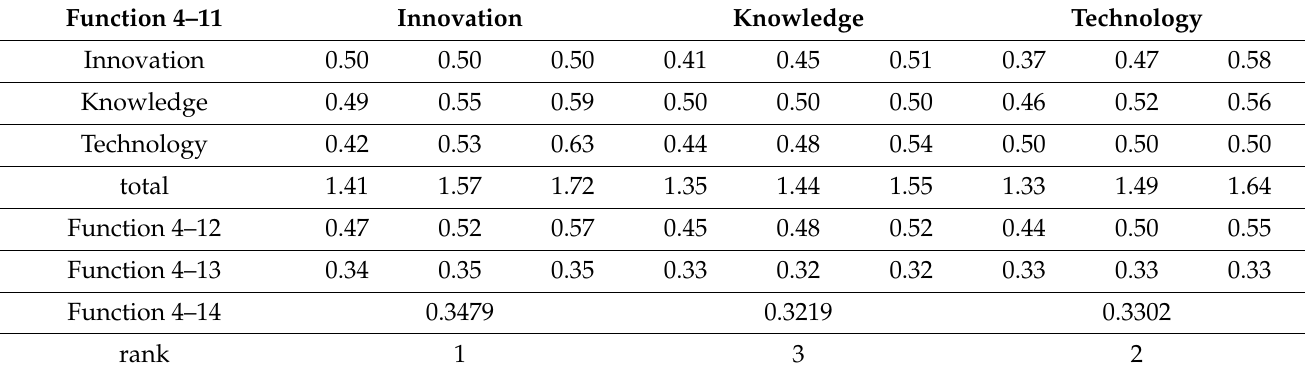
Table A7. Aviation companies’ weights of attributes of the epistemic